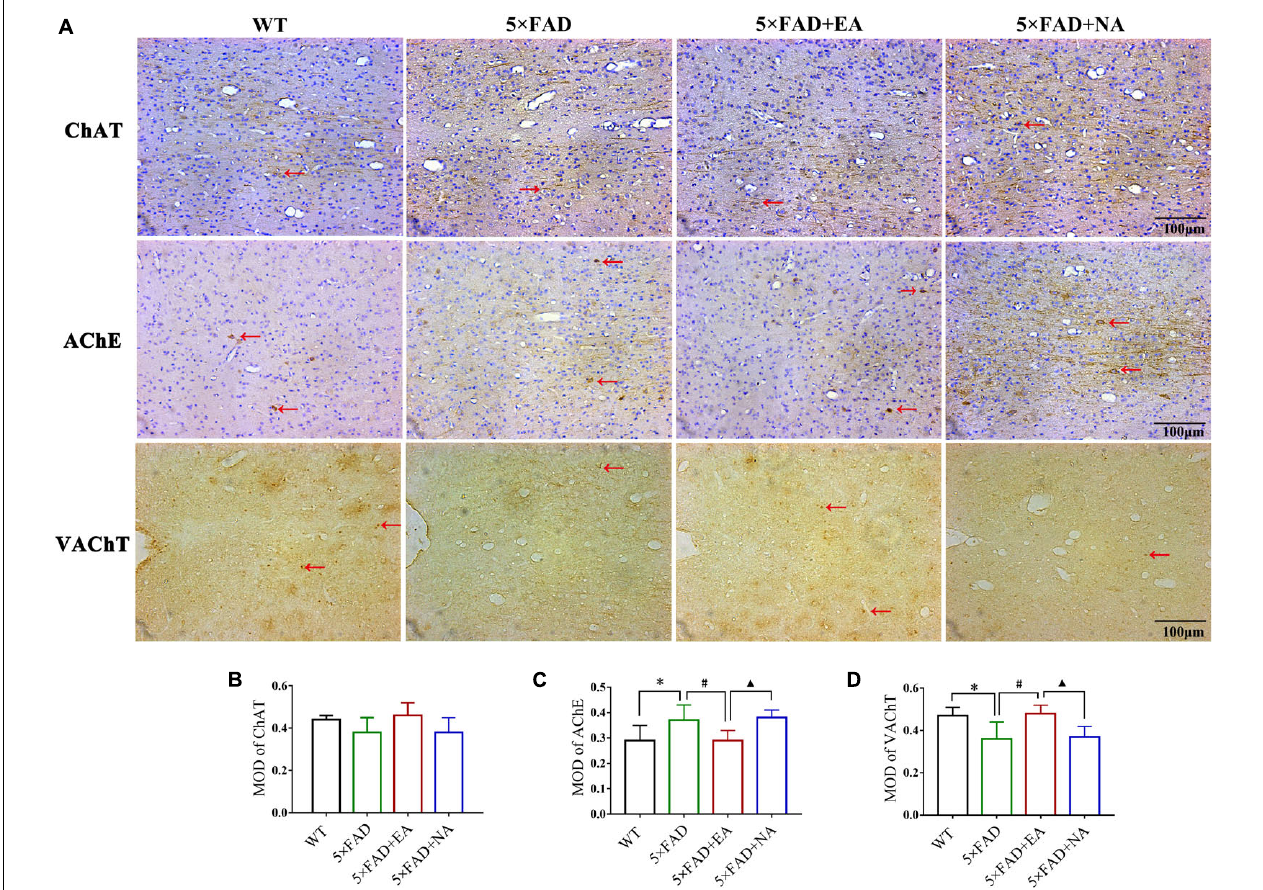
FIGURE 6 | Electro-acupuncture (EA) treatment regulates cholinergic biomarkers of MS/VDB by immunohistochemistry. ChAT and AChE express in the cytoplasm and nerve fibers (brown), and the nuclei are stained with hematoxylin (blue). VAChT expression is granular (brown), without hematoxylin staining of the nuclei. (A) Representative 200 × photomicrographs of choline acetyltransferase (ChAT) (Top), enzyme acetylcholinesterase (AChE) (Middle), and vesicular acetylcholine transporter (VAChT) (Bottom) expression. (B–D) Statistical results of mean optical density (MOD) of ChAT, AChE and VAChT in MS/VDB. Red arrows indicate positive protein expression, scale bar = 100 µ m. Data are represented as mean ± SD, n = 4/group (* p < 0.05 and ** p < 0.01 vs WT group; # p < 0.05 vs 5 × FAD group; (cid:78) p < 0.05 vs 5 × FAD + EA group). ChAT, choline acetyltransferase; AChE, enzyme acetylcholinesterase; VAChT, vesicular acetylcholine transporter; MOD, mean optical